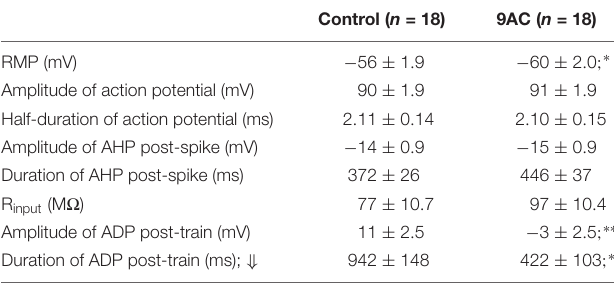
TABLE 2 | Anthracene-9 (cid:48) -carboxylic acid (9AC) affects only